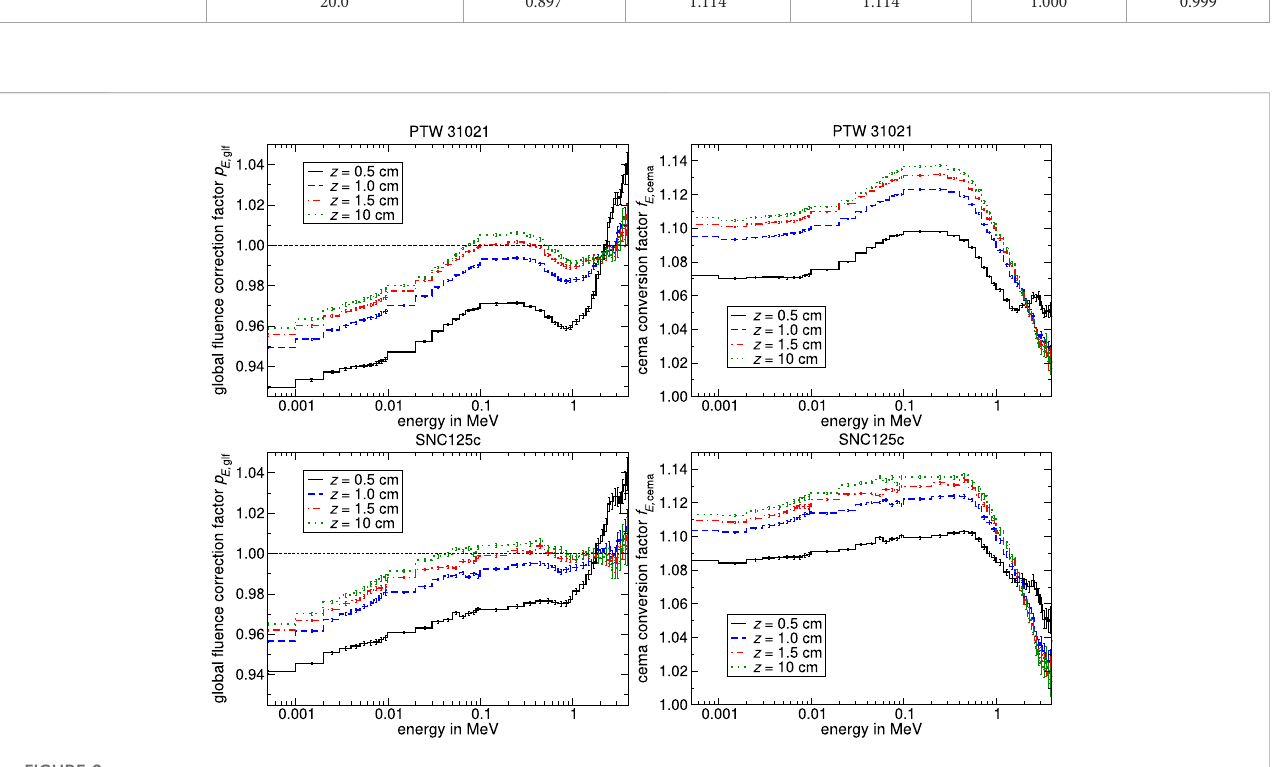
FIGURE 8 MonteCarlocalculatedglobal fl uencecorrection factors p E ,glf andcemaconversionfactors f E , cema (cid:1) p E , glf · s SA w , med differential inenergyfor cylindrical air- fi lled ionization chambers placed with their shifted reference point at different depths in water. The uncertainty varies depending on energy in a range of 0.05% – 1%.